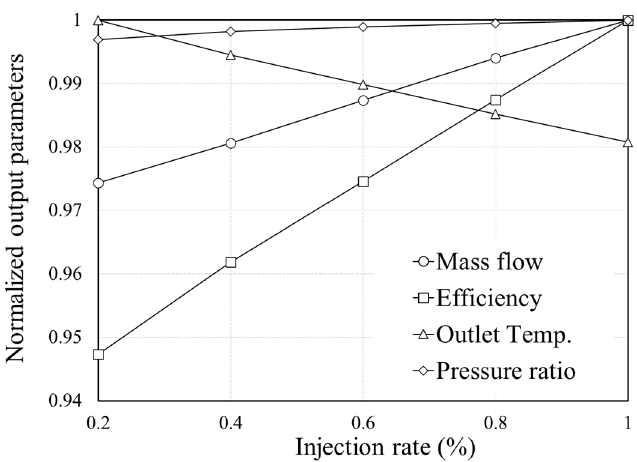
Figure 12. Effect of the different mass flow rates on the centrifugal compressor performance (droplet diameter, d r = 2 µ m) at the design point.